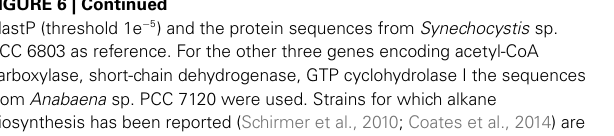
highlighted and underlined. Alkanes were measured either directly in cyanobacterial cell extracts (mainly penta- or hepta-decane) or indirectly by alkane detection in recombinant E. coli strains expressing the corresponding ado orthologs in combination with the aar gene from S. elongatus